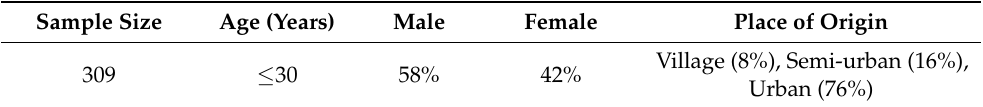
Table 1. Demography for the